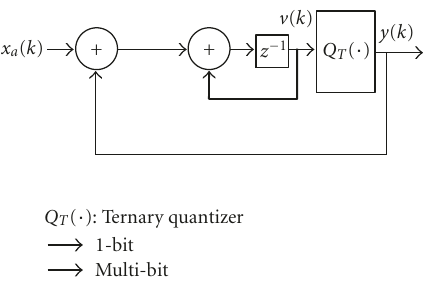
Figure 1: The structure of a first-order ternary sigma-delta